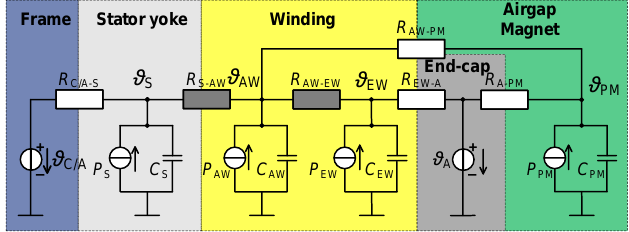
Figure 39. Improved low-order grey box thermal model [84].